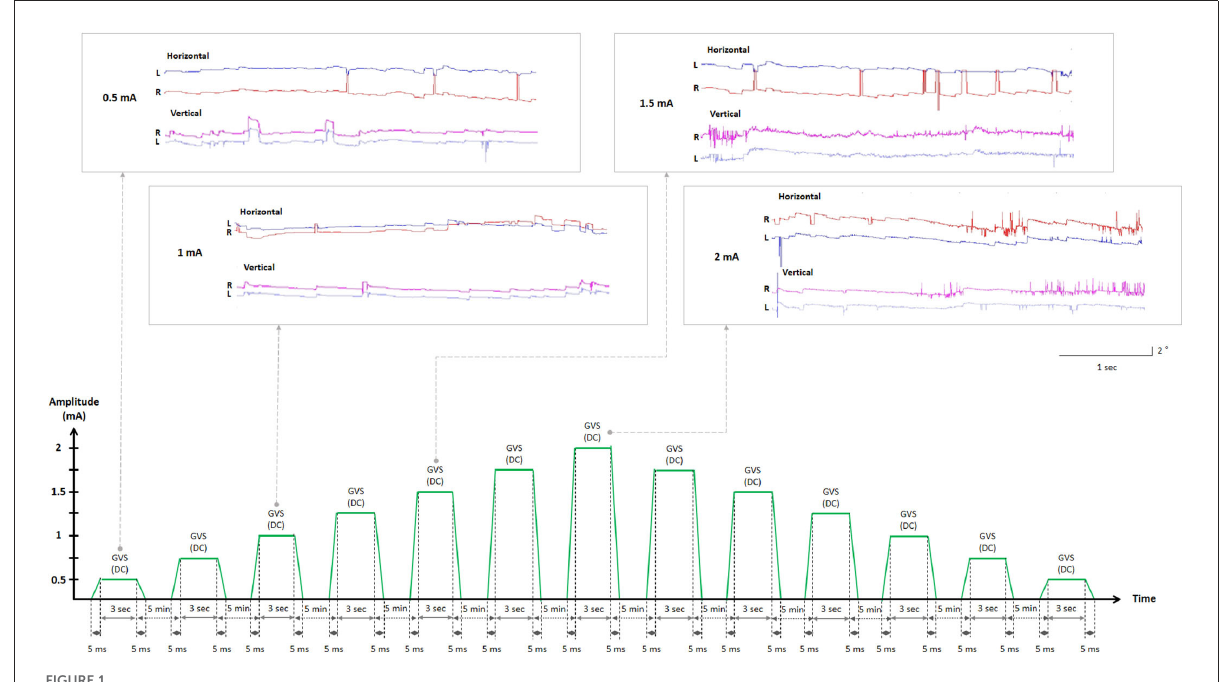
FIGURE1 Experimental design flowchart. Representations of ocular movements during GVS application (in the boxes). The two-step approach to determining GVS thresholds. GVS, galvanic vestibular stimulation; DC, direct current; L, left eye (blue); R, right eye